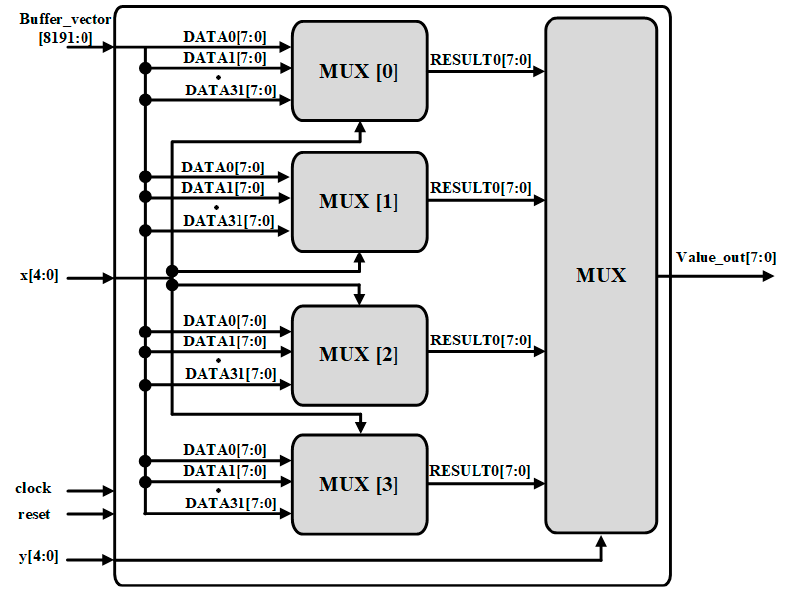
Figure 7. Window selector structure.